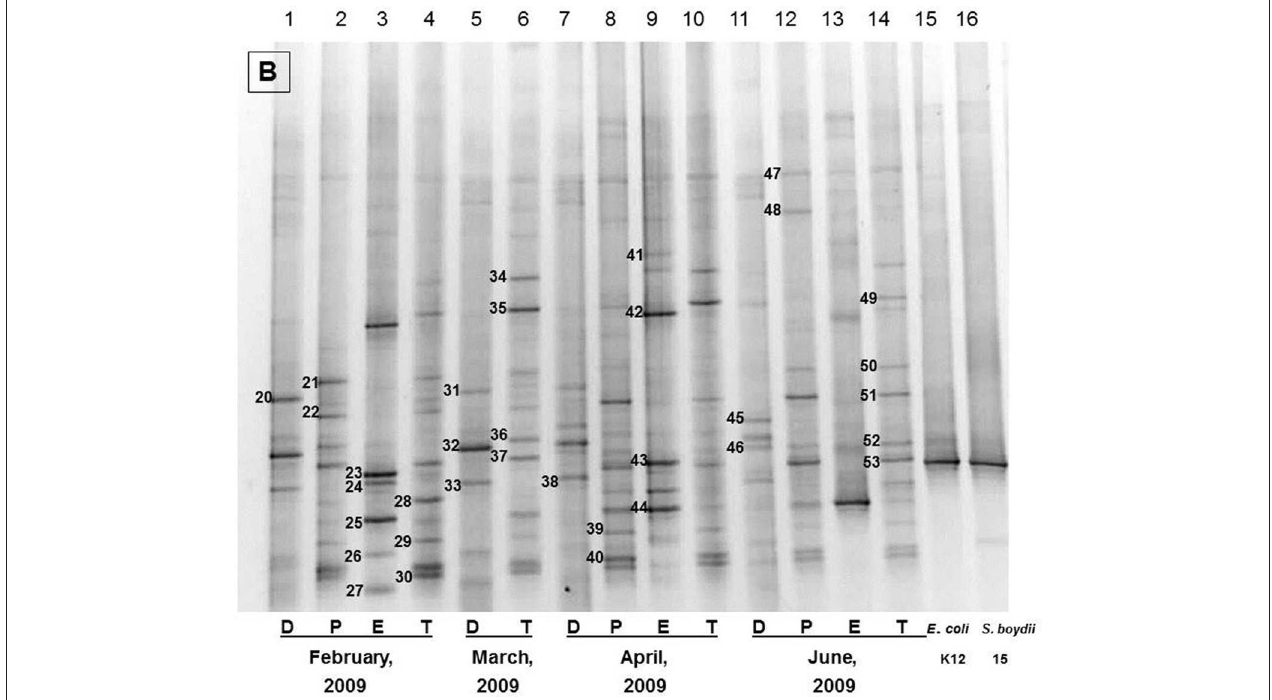
FIGURE 1 | The representative DGGE profiles of bacterial community of Brahmanbaria pond in February 2009–July 2009. D, P, E, and T stand for the Direct, Pre-enriched, Enriched, and Total heterotrophic DNA samples.